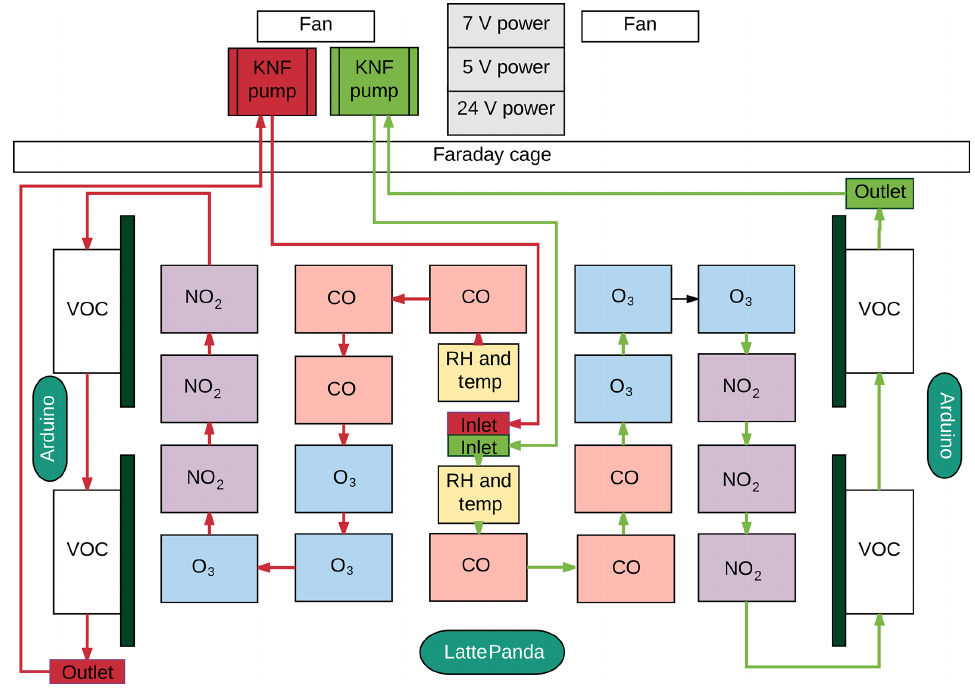
Table 1. Summary of sensors used within the instrument.